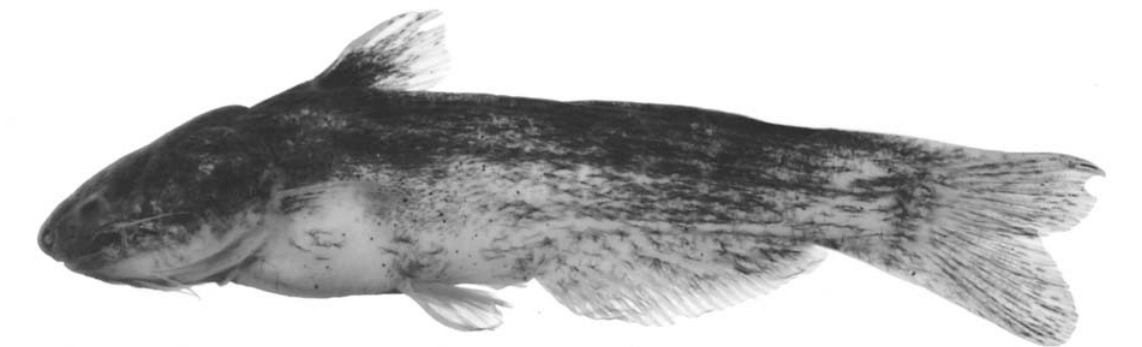
Fig. 53 . Denticetopsis seducta , new species, holotype, ANSP 178466, 39 mm SL; Peru, Loreto, Caño “Sabolito,” small creek on terra firma approximately 25 mi (= 40 km) south of Iquitos (4°14’45"S,